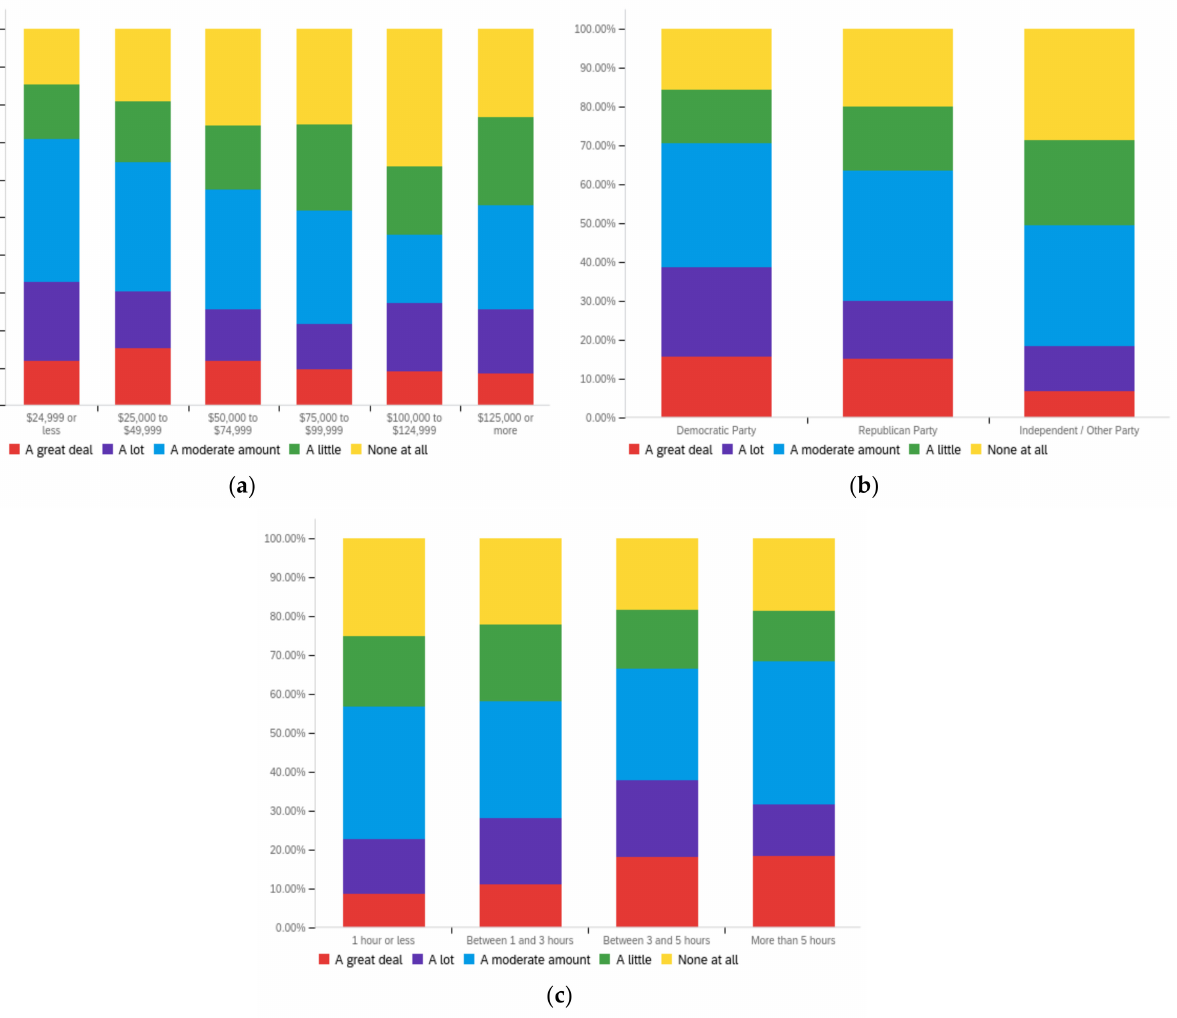
Figure A29. Article virality—others’ perception impact by: ( a ) income level (top left), ( b ) political affiliation (top right) and ( c ) online usage (bottom).